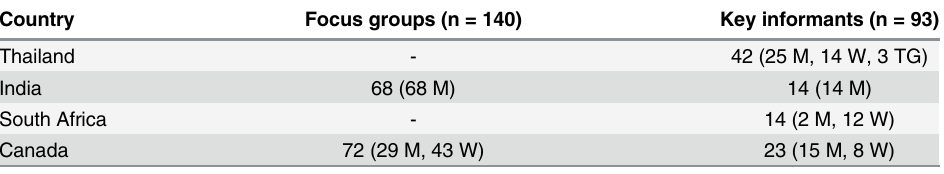
Table 1. Case study participants (and gender) by country and method (n = 233).